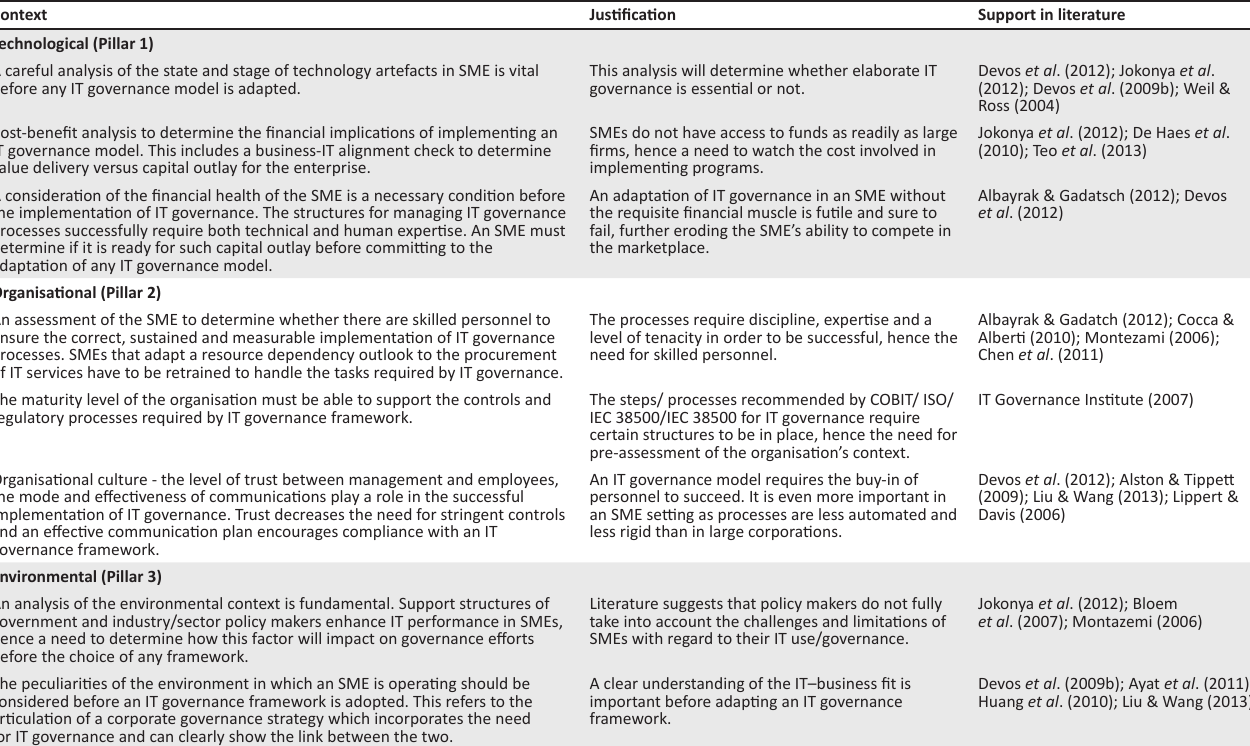
TABLE 1: Components of the key pillars of the TOE contexts for analysis before implementing IT governance in an SME.